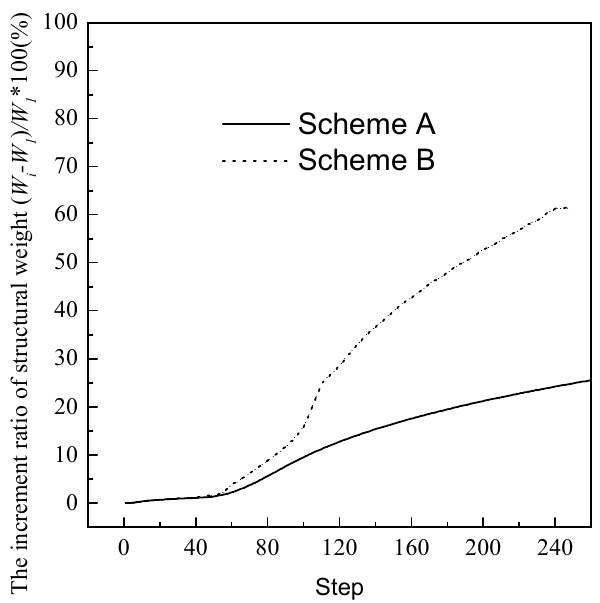
Figure 8. The change ratio of the structural weight of Schemes A and B.